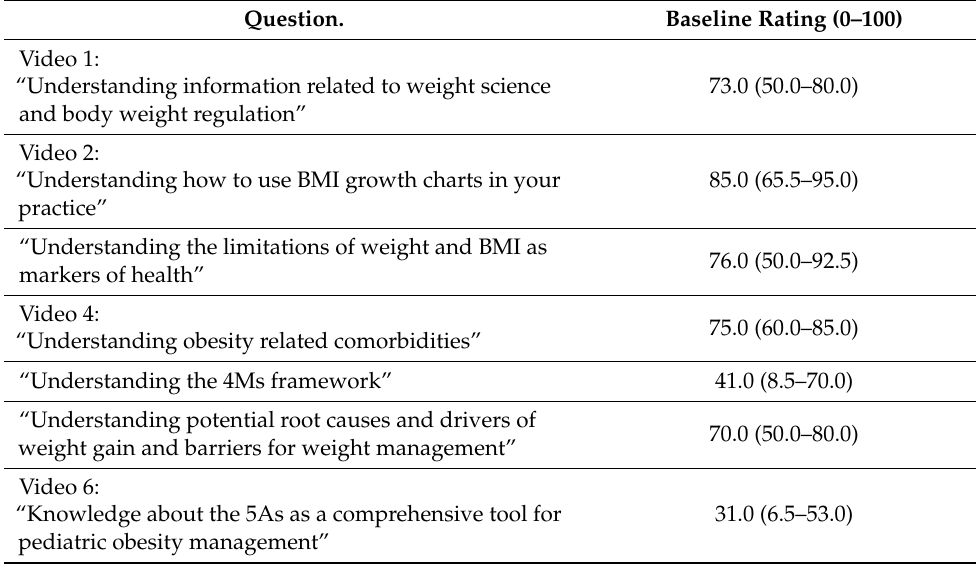
Table 4. Baseline knowledge scores 1